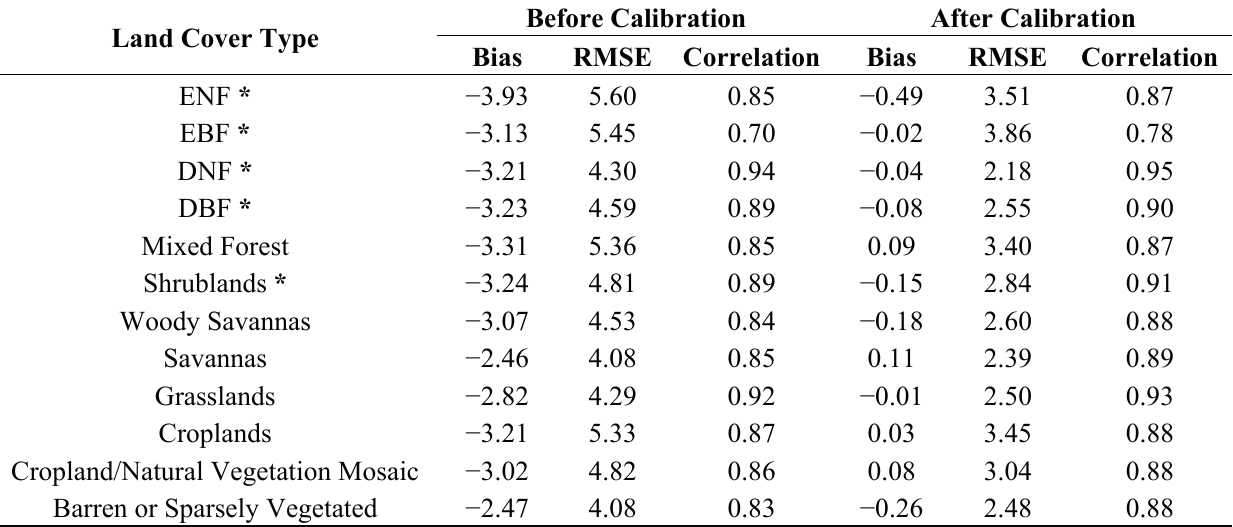
Table 6. Summary of sensor ascending (PM) orbit T Mean Square Error (RMSE) differences and Correlation Coefficients across all frequencies and polarizations estimated from overlapping AMSR and MWRI records before and after calibration for major IGBP land cover type areas within the global domain. T b